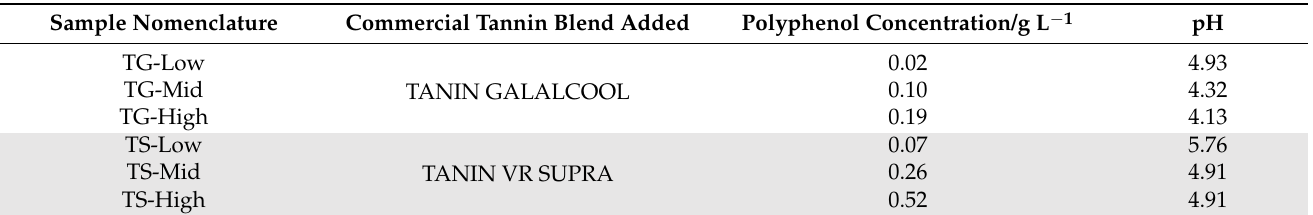
Table 1. Aqueous solutions used for QCM-D measures: sample nomenclature, commercial tannin blend dissolved in water, polyphenol concentration (calculated), and measured pH.